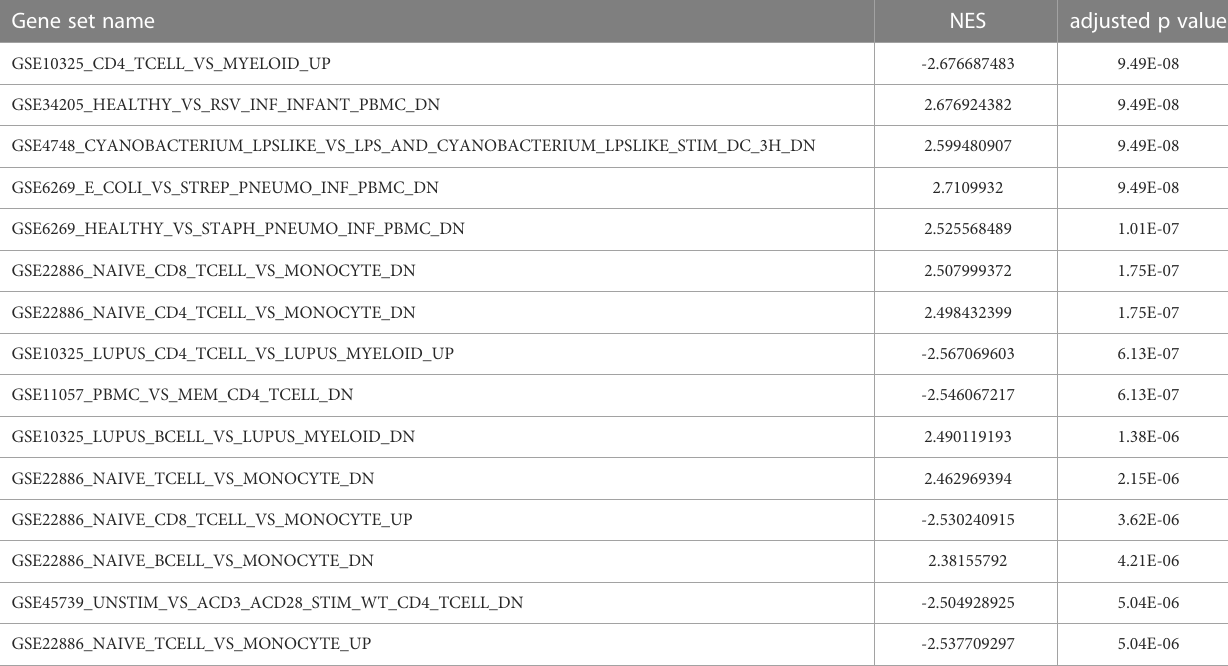
TABLE 4 Top 15 signi fi cant immunological signatures enriched by immunity in GSEA of the AISD grade of